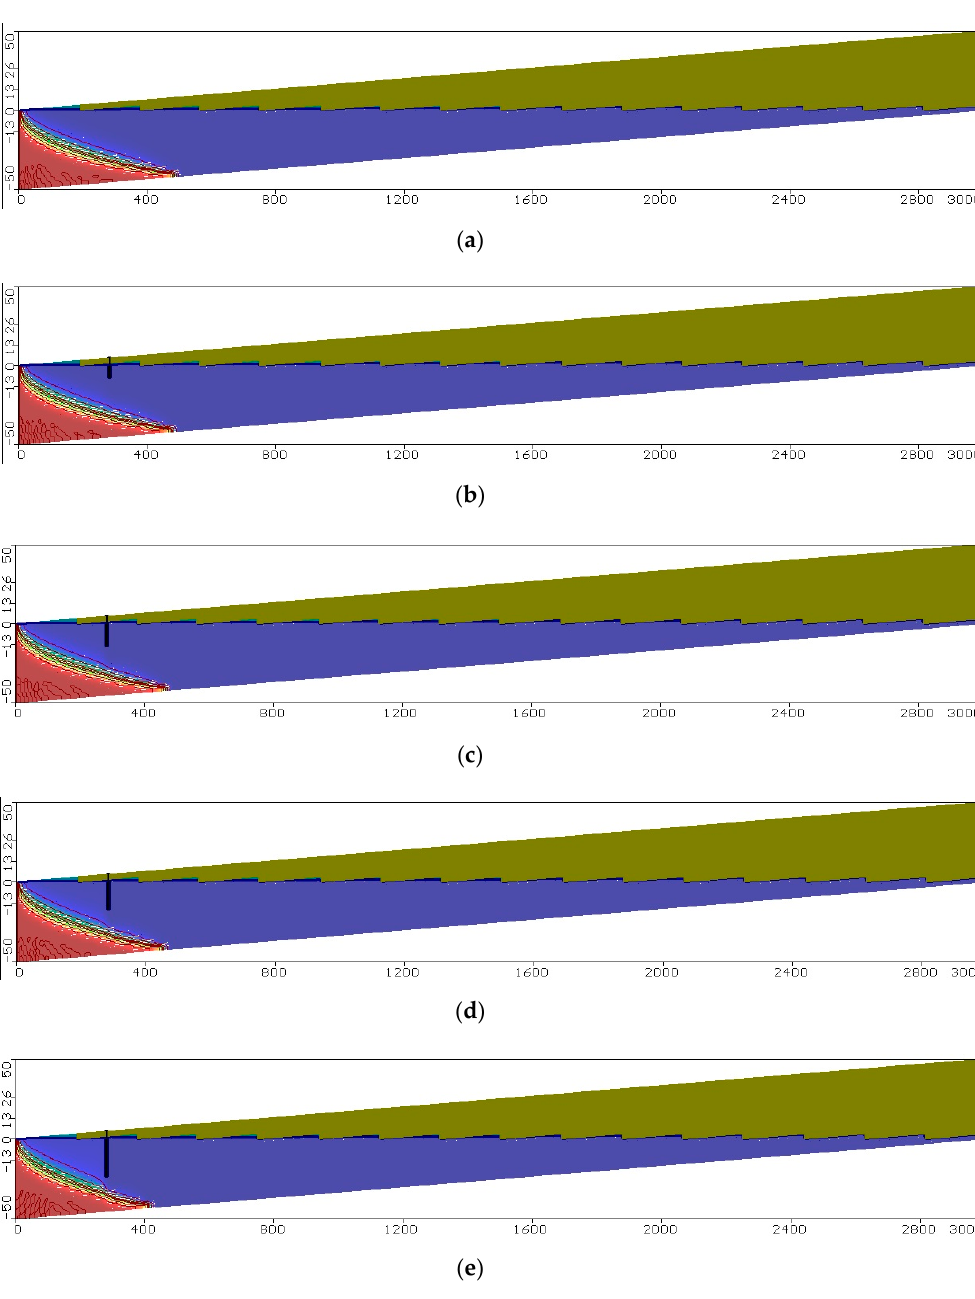
Figure A3. Saltwater distribution (in mg/L) in the Akrotiri aquifer for ( a ) the steady state and embedded barrier wall with X b / L o = 0.4 and ( b ) d b / d = 0.2, ( c ) d b / d = 0.3, ( d ) d b / d = 0.4, ( e ) d b / d = 0.5, ( f ) d b / d = 0.6, ( g ) d b / d = 0.7 and ( h ) d b / d = 0.8.